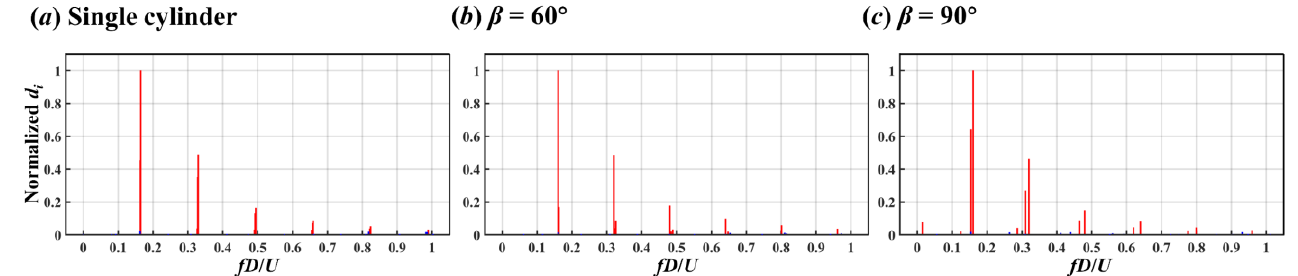
ing cylinders in 60° ( b ) and 90° ( c ) arrangements. crossing cylinders in 60 ◦ ( b ) and 90 ◦ ( c )